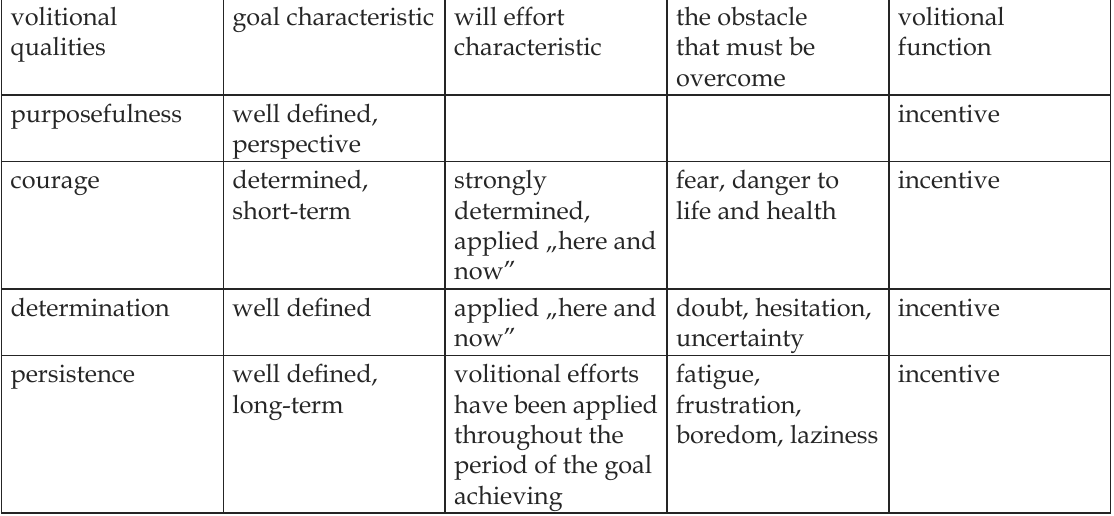
Table 4. The signs of volitional